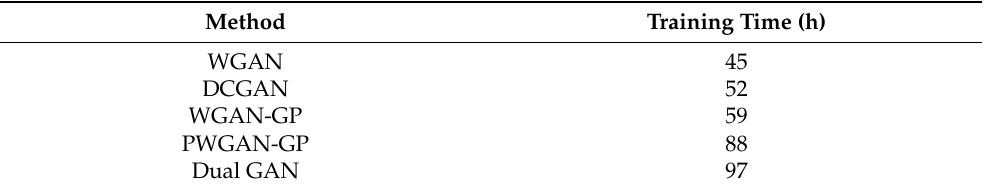
Table 6. Time spent on model